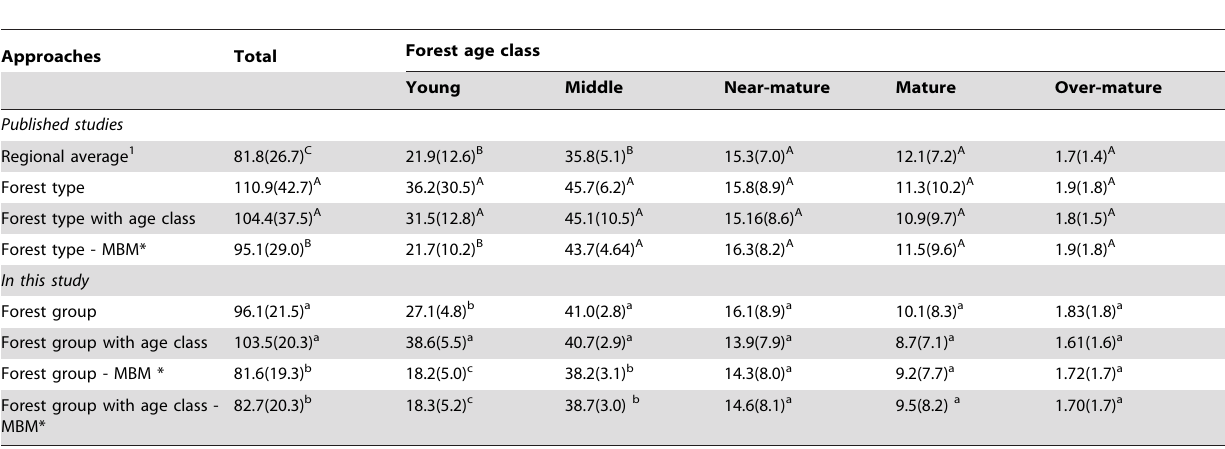
Table 3. Average estimate of forest biomass carbon storage (TgC) derived from different approaches based on data from 2 nd –8 th National Forest Inventories.